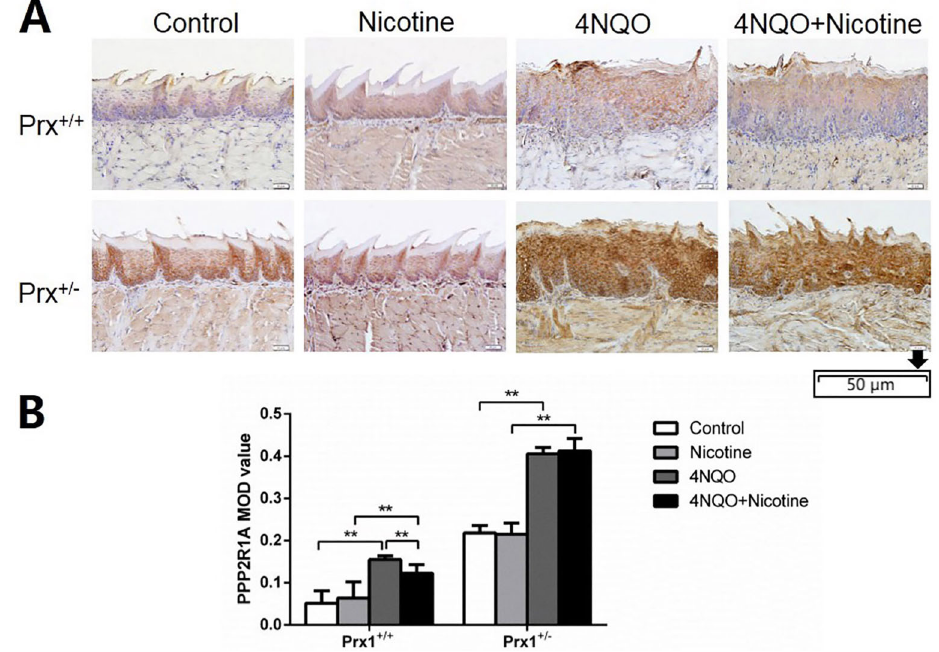
Figure 2. Immunohistochemical analysis of PPP2R1A in the tongue oral leukoplakia tissues of Prx1 + / + and Prx1 + / (cid:1) mice. A , Representative immunohistochemistry images of PPP2R1A ( (cid:3) 200, scale bar 50 m m). B , The integral optical density (IOD)/ measurement area (MOD) values are reported as means ± SE. **P o 0.01 (ANOVA). 4NQO: